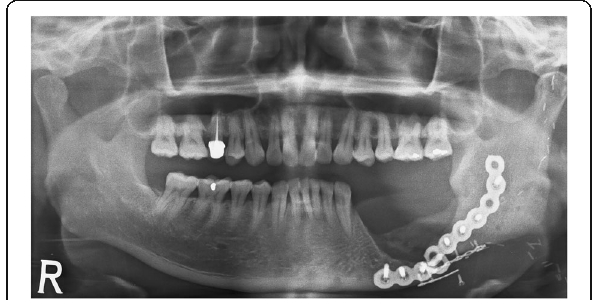
Fig. 1 Pathologic fracture of the left mandibular body was observed in the panoramic